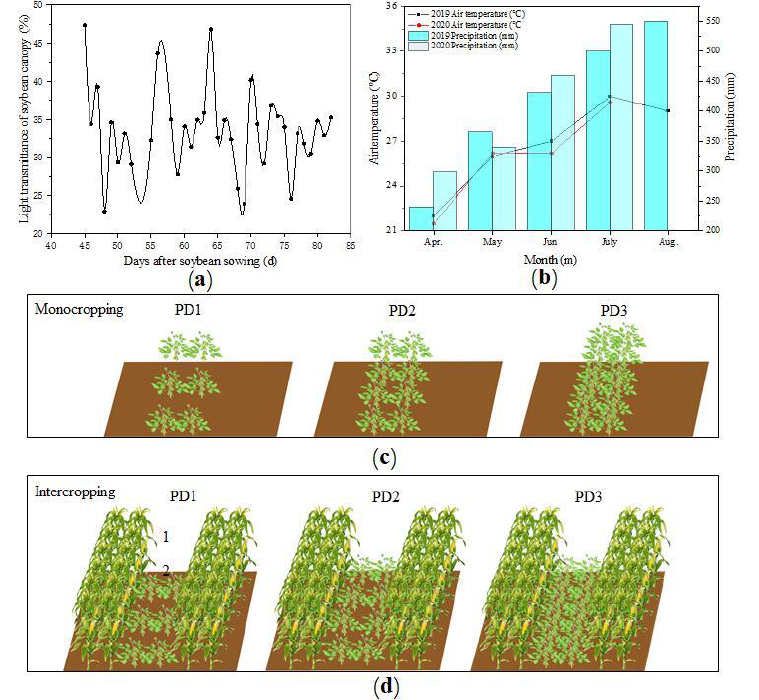
Figure 1. Multiple planting densities (PD1, PD2, and PD3) having a total number of 17 plants m − 2 , 20 plants m − 2 , and 25 plants m − 2 , respectively, represented by ( c ) and ( d ) monoculture soybean and maize–soybean strip intercropping system. The dynamic change of light transmittance of soybean canopy from point 1 to point 2 showed in ( a ) and ( d ). The monthly average air temperature and precipitation from April to August were shown in figure ( b ).